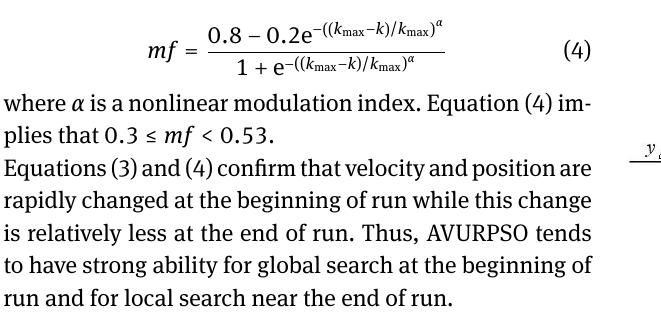
Figure 2: A PID controller using the optimization